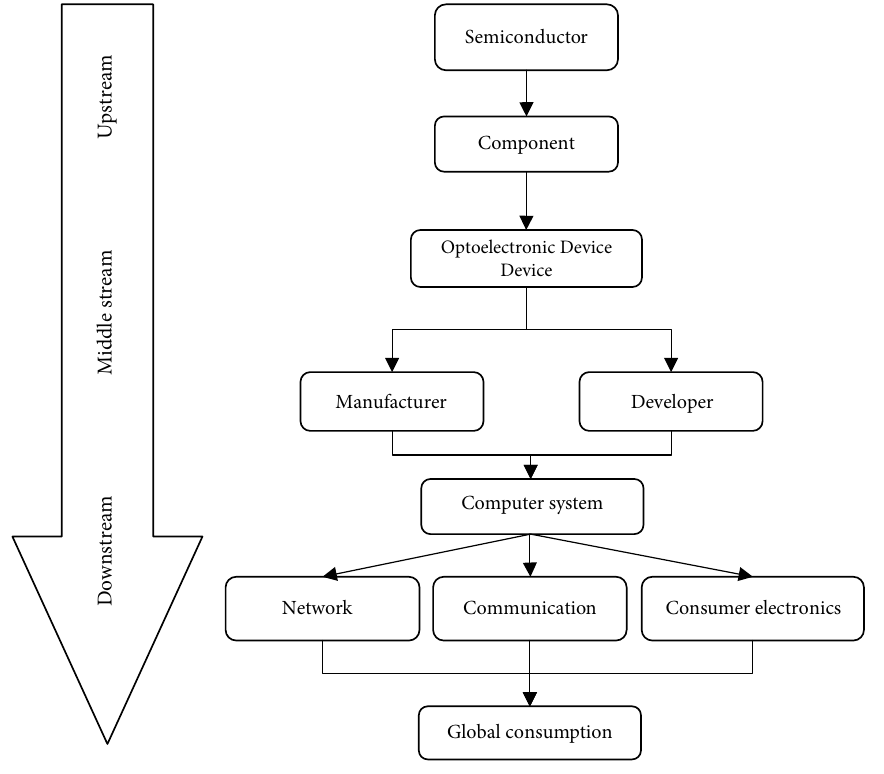
Fig. 1. The electronic industrial